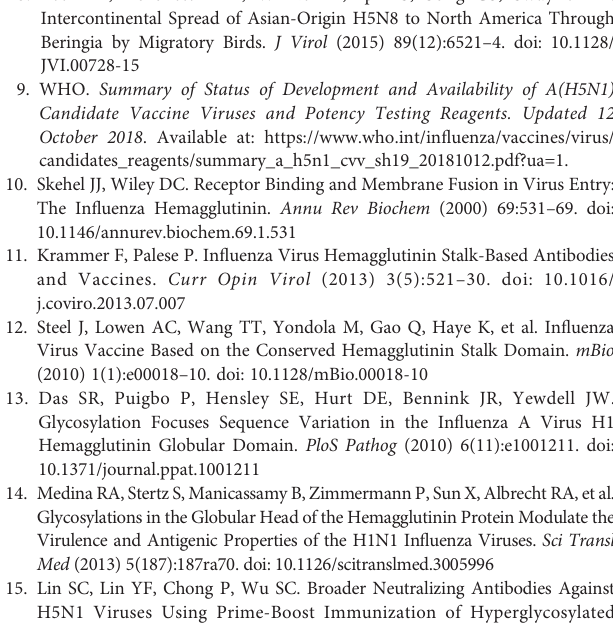
Supplementary Figure 1 | Structural diagrams and site-speci fi c glycan-masking and glycan-unmasking antigens. Amino acid sequences for (A) rH5-dm/st2 ( 127 NSS+ 138 NGT+ 484 AGT) and (B) rH5-tm/st2 ( 83 NSS+ 127 NSS+ 138 NGT+ 484 AGT). The mutant sites are displayed by arrows. Three-dimensional structural models for (C) rH5-dm/st2 and (D) rH5-tm/st2 (PyMol modeling software; PDB ID: 2IBX). Gray color, HA trimeric structure; yellow, globular head; cyan, stem region; magenta, glycan-masking mutant sites; red, glycan-unmasking mutant site. Supplementary Figure 2 | IgG antibody titers against homologous H5N1 strain were elicited by immunizations with two-dose rH5 protein or adenovirus vector- prime + rH5 protein-boost regimen. Groups of BALB/c mice were immunized by rH5 + rH5: two-dose rH5 proteins with PELC/CpG adjuvant and Ad-H5 (prime) + rH5 (boost): fi rst-dose Ad-H5 and second dose rH5 with PELC/CpG adjuvant. The H5-speci fi c IgG titers as determined by rH5-coating ELISA (A, B) and H5N1 RG14 inactivated virus-coating ELISA (C, D) . Supplementary Figure 3 | Serum neutralization curves against the homologous and heterologous H5N1 viruses. Neutralization curves of antisera elicited by the rH5 + rH5 regimen against (A) KAN-1 (clade 1), (B) Qinhai (clade 2.2), (C) Hubei (clade 2.3.2.1a), and (D) Anhui (clades 2.3.4). Neutralization curves of antisera elicited by the Ad-H5 (prime) + rH5 (boost) regimen against (E) KAN-1 (clade 1), (F) Qinhai (clade 2.2), (G) Hubei (clade 2.3.2.1a), and (H) Anhui (2.3.4). Supplementary Figure 4 | Antisera against the heterosubtypic pH1N1 (A/ California/04/2009) and H3N2 (A/Udorn/307/1972) viruses. Immunization with rH5 + rH5 regimen: (A) hemagglutinin inhibition against pH1N1, (B) hemagglutinin inhibition against H3N2, (C) PRNT neutralization curves against pH1N1, (D) PRNT neutralization curves against H3N2; Immunization with Ad-H5 (prime) + rH5 (boost) regimen: (E) hemagglutinin inhibition against pH1N1, (F) hemagglutinin inhibition against H3N2, (G) PRNT neutralization curves against pH1N1, (H) PRNT neutralization curves against